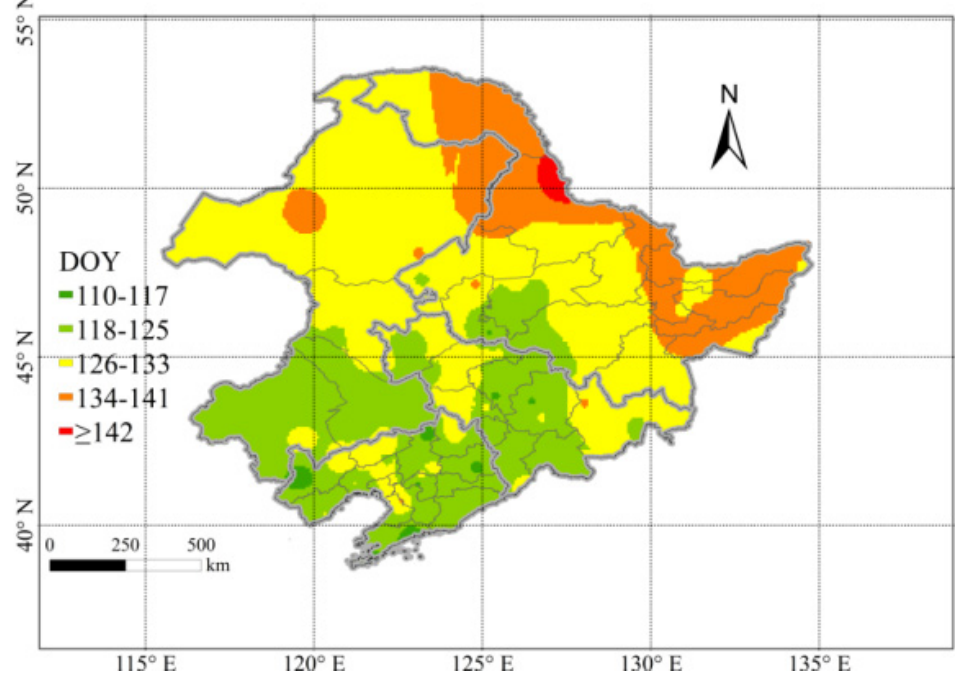
Figure 3. Maize sowing stage (SW) in Northeast China. Note: as all sowing dates were known there was no requirement for a reconstructed data set.